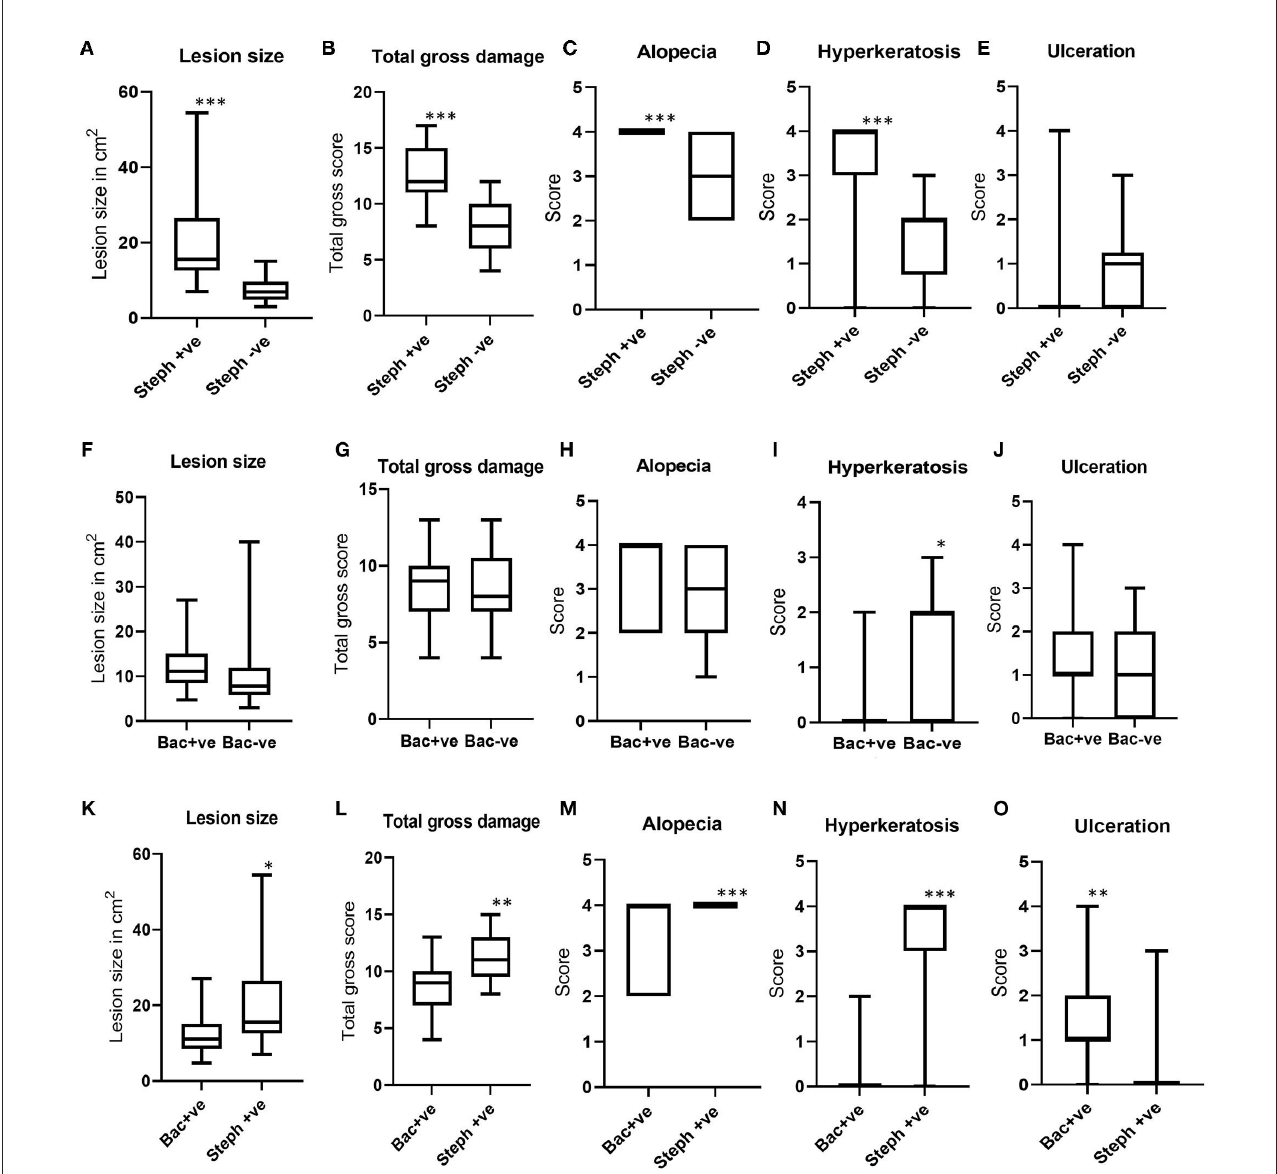
FIGURE4 Boxplots showing the distribution of lesion areas and pathology scores for total gross damage, alopecia, ulceration, and hyperkeratosis. (A–E) Show gross pathology comparisons between Stephanofilaria positive (Steph + ve) and negative (Steph -ve) lesions; (F–J) Show gross pathology comparisons between bacteria positive (Bac + ve) and negative (Bac-ve) lesions; (K–O) Show gross pathology comparisons between Steph + ve and Bac + ve lesions (* P < 0.05, ** P < 0.01, *** P <